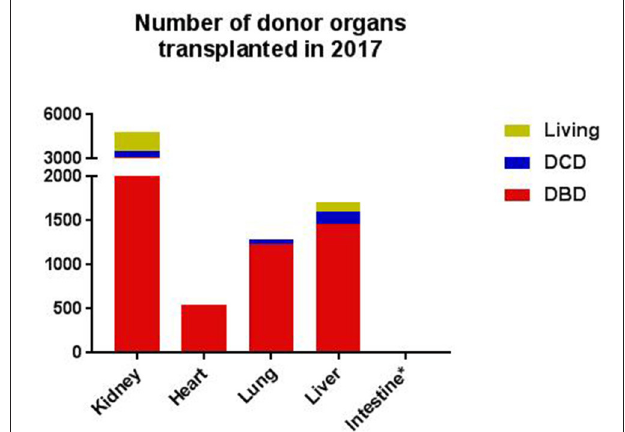
FIGURE 2 | The number of donor organs transplanted in 2017, as documented by Eurotransplant, per type of donor, per organ (4, 5). *In 2017, the number of intestines donated was six. DBD, donation after brain death; DCD, donation after cardiac death. The data was consulted on the 25th of October 2018, permission for publication was